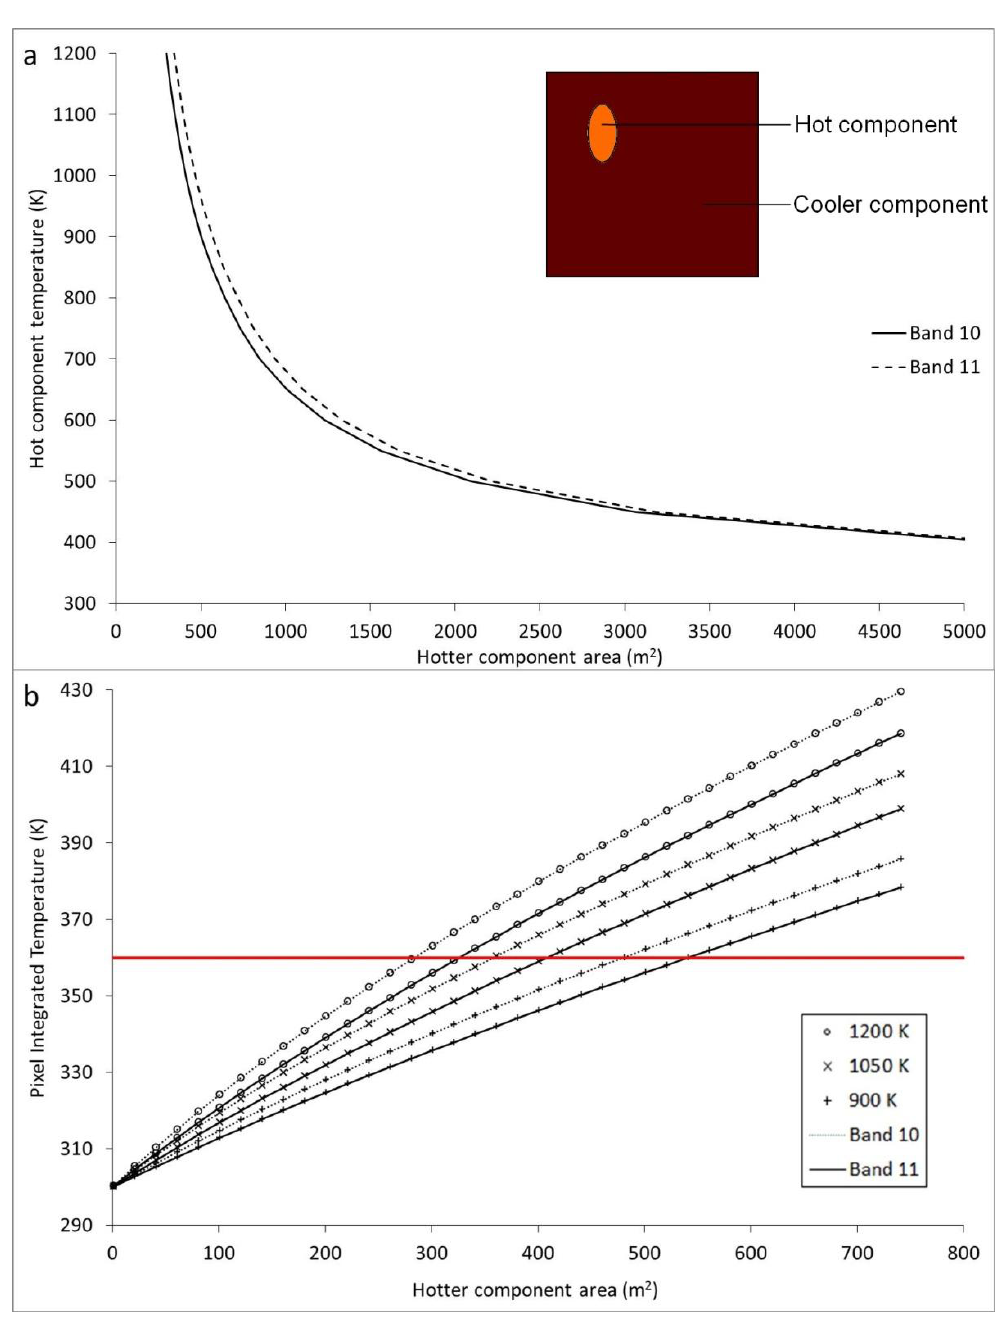
Figure 3. ( a ) Simulated volcanic-like surfaces being viewed within one TIRS pixel, with two sub-pixel components of varying size and temperature which would produce a TIRS pixel integrated temperature at the peak of detection for 10,000 m 2 TIRS pixels: 360 K [1]; this assumes a cooler component temperature of 300 K. Inset: a representation of the theoretical heterogeneous pixel assumed in these scenarios, with a small hot component representing high temperature elements such as fresh lava or cracks in the carapace of a lava dome, and a larger cooler component (here at 300 K) representing the non-volcanic background surface. ( b ) The range of pixel integrated temperatures (PITs) that individual TIRS pixel detection components would detect as emitted from a surface with a cooler component (or background) temperature of 300 K and a hotter component with the characteristics displayed. The red line represents the limit of detection for